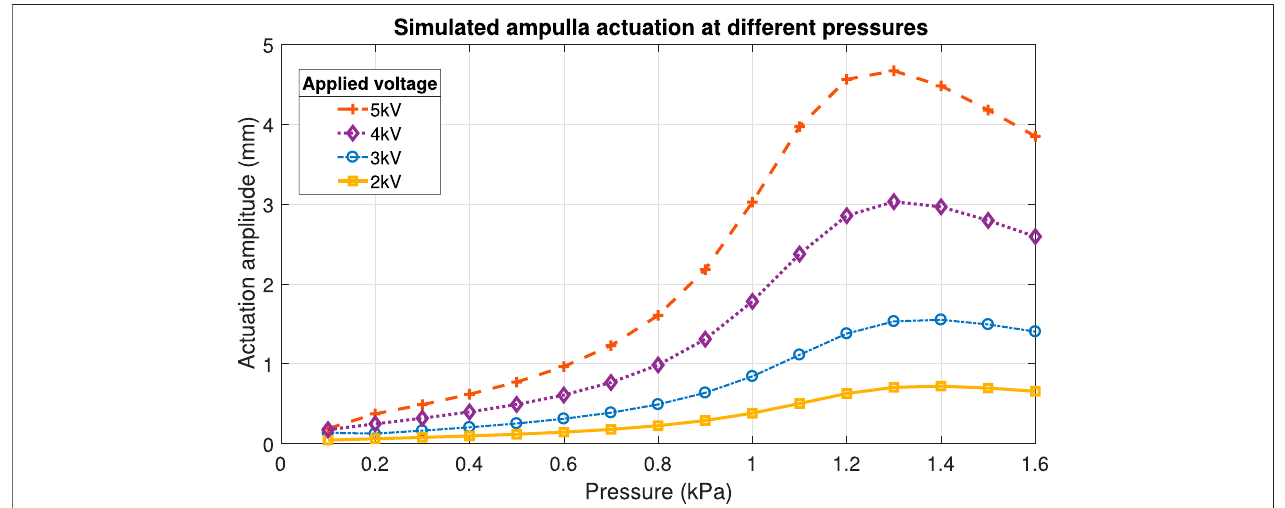
FIGURE 9 | Finite element modelling of the actuation amplitude of the MIDA ampulla at varying pressures and applied voltages.